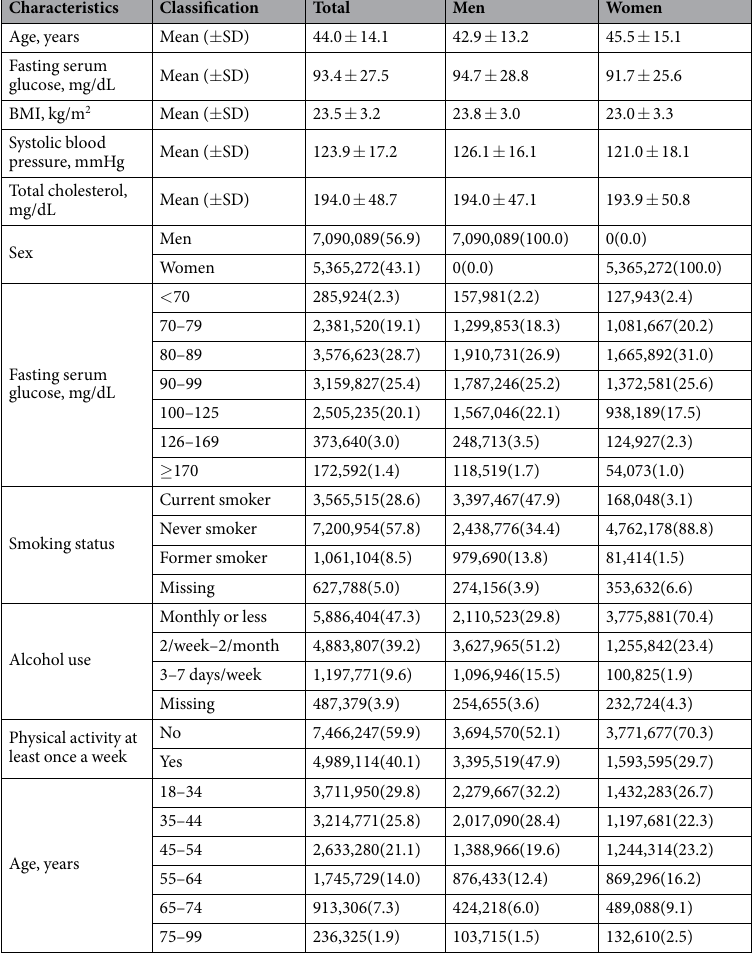
Table 1. Characteristics of participants (n = 12,455,361). Abbreviation: BMI, body-mass index; SD, standard deviation. The difference for each characteristic was tested using ANOVA and the chi-square test, and the p-value for each variable, including total cholesterol, was < 0.0001. To convert glucose from mg/dL to mmol/L, multiply by 0.0555. To convert cholesterol from mg/dL to mmol/L, multiply by 0.0259.